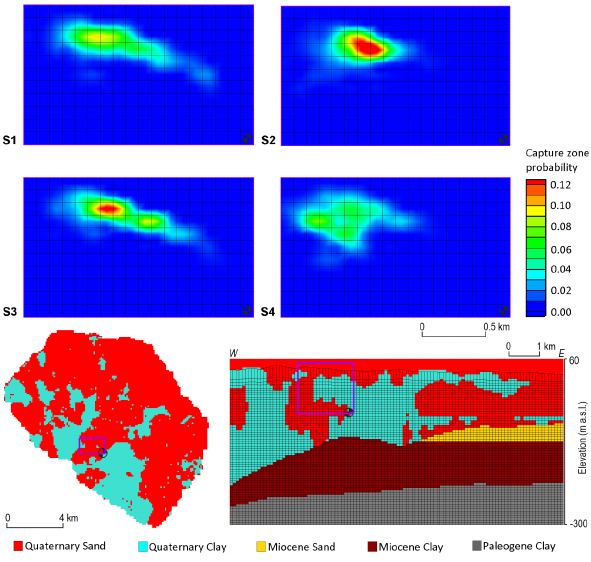
Figure 11: The probabilistic capture zone of Well 3 from each scenario. The well location is 2 Figure 11. The probabilistic capture zone of Well 3 from each sce- illustrated in relation to the geological structure of the TI1. 3 nario. The well location is illustrated in relation to the geological structure of the TI1. Fig. 8. Scenarios on the first row use TI1 while the